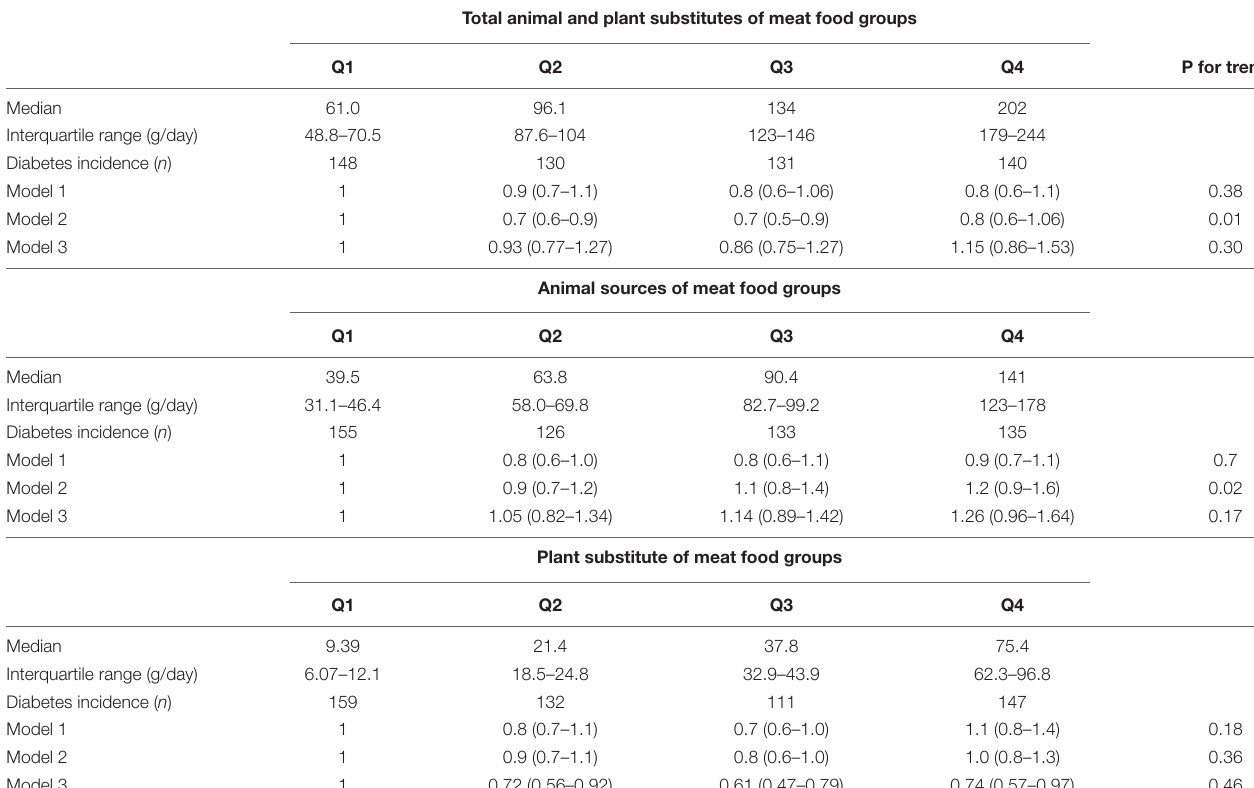
TABLE 2 | Hazard ratios (HRs, 95% CI) of diabetes incidence across quartiles of animal and plant sources of meat food groups.